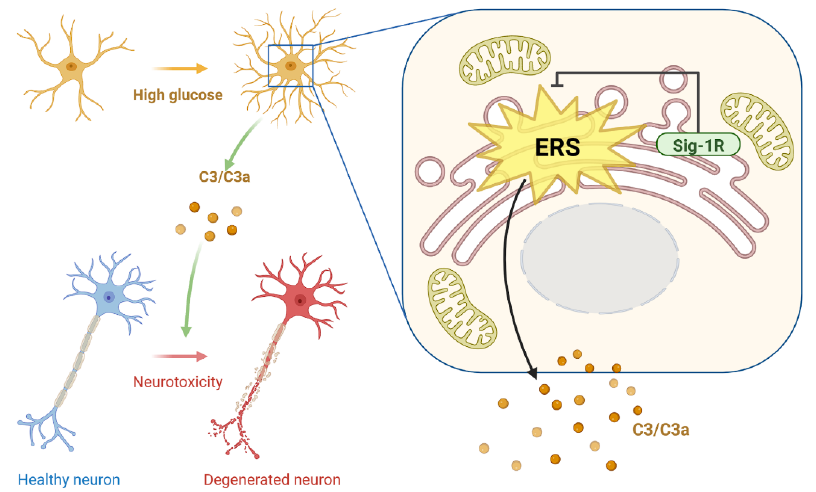
Figure 8. Diagram depicting study mechanism. Activation of astrocytic Sig-1R suppressed HG-induced enhancement in ER-mitochondrion contact, ERS pathway, and C3/C3a production, further restoring damaged neurons. Sig-1R, sigma-1 receptor; HG, high glucose; ER, endoplasmic reticulum; ERS, ER stress; C3/C3a, complement component 3/3a.